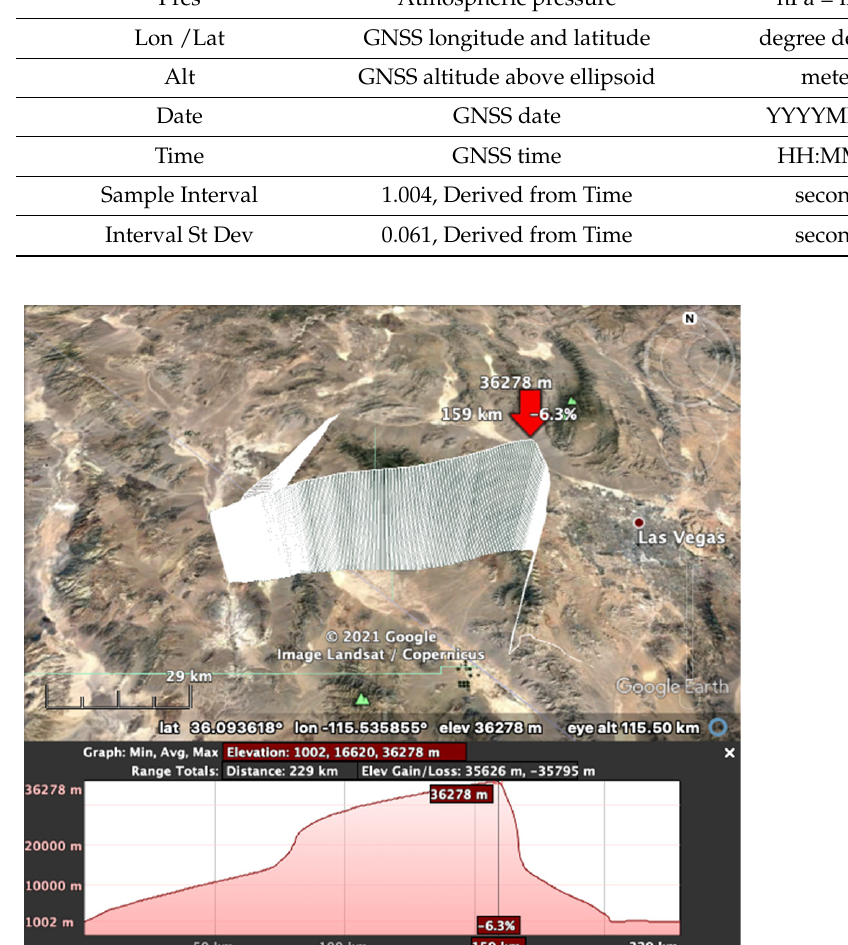
Figure 3. Balloon trajectory for complete event. The Skyfall case study concentrates on the rapid descent from its peak height.